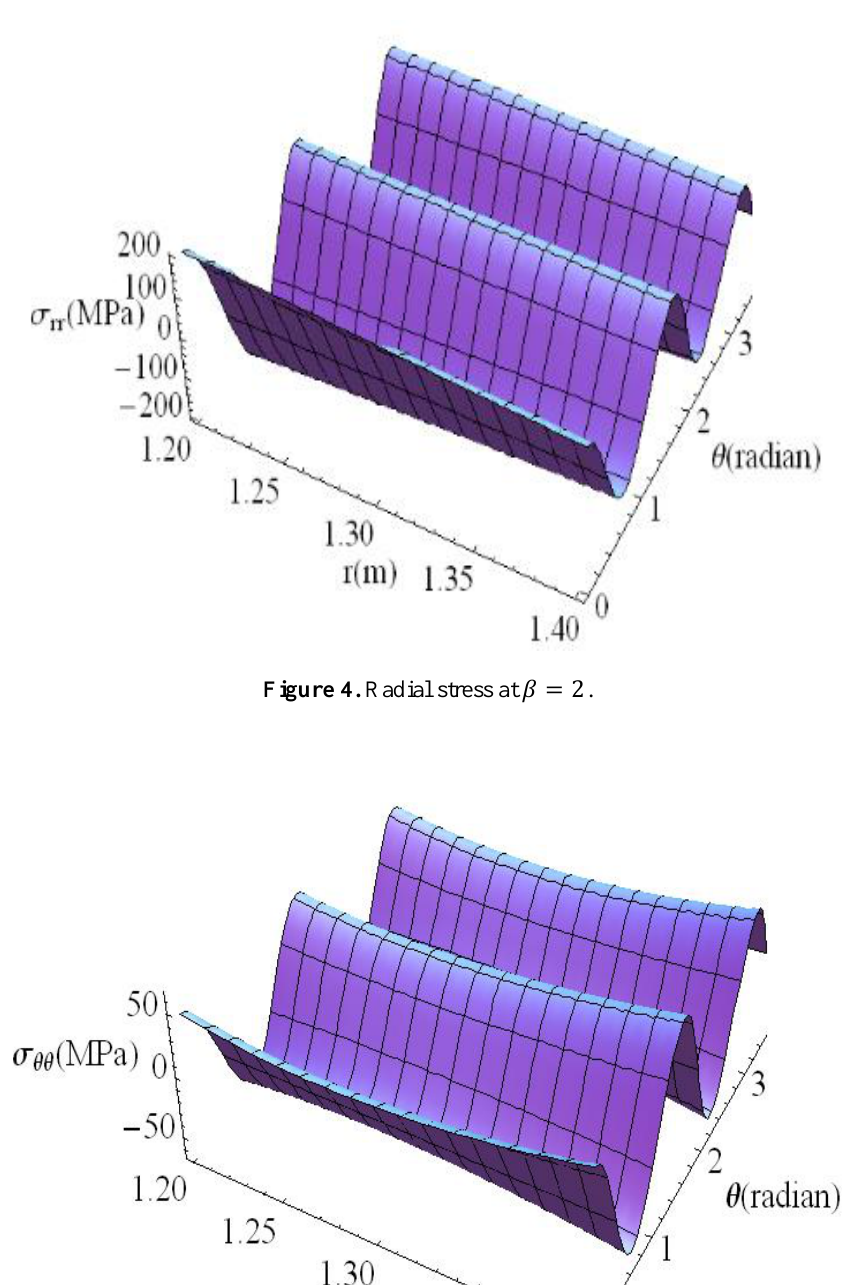
1123 | Vol. 6, No. 4, 2021